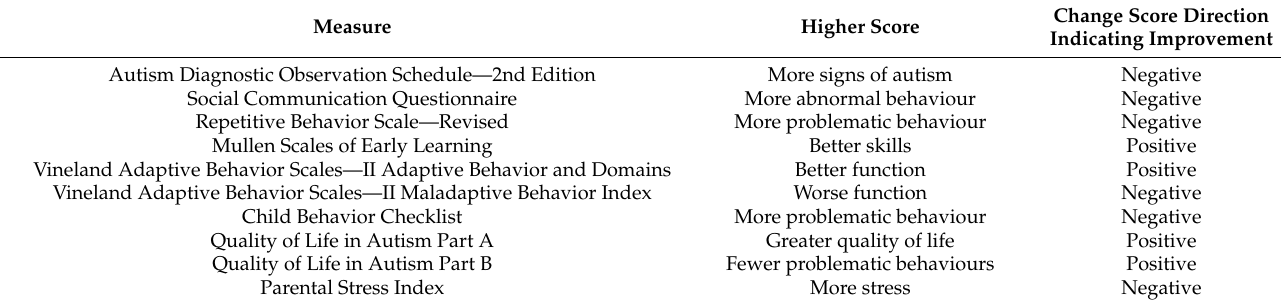
Table 2. Meaning of higher scores and change score direction for each